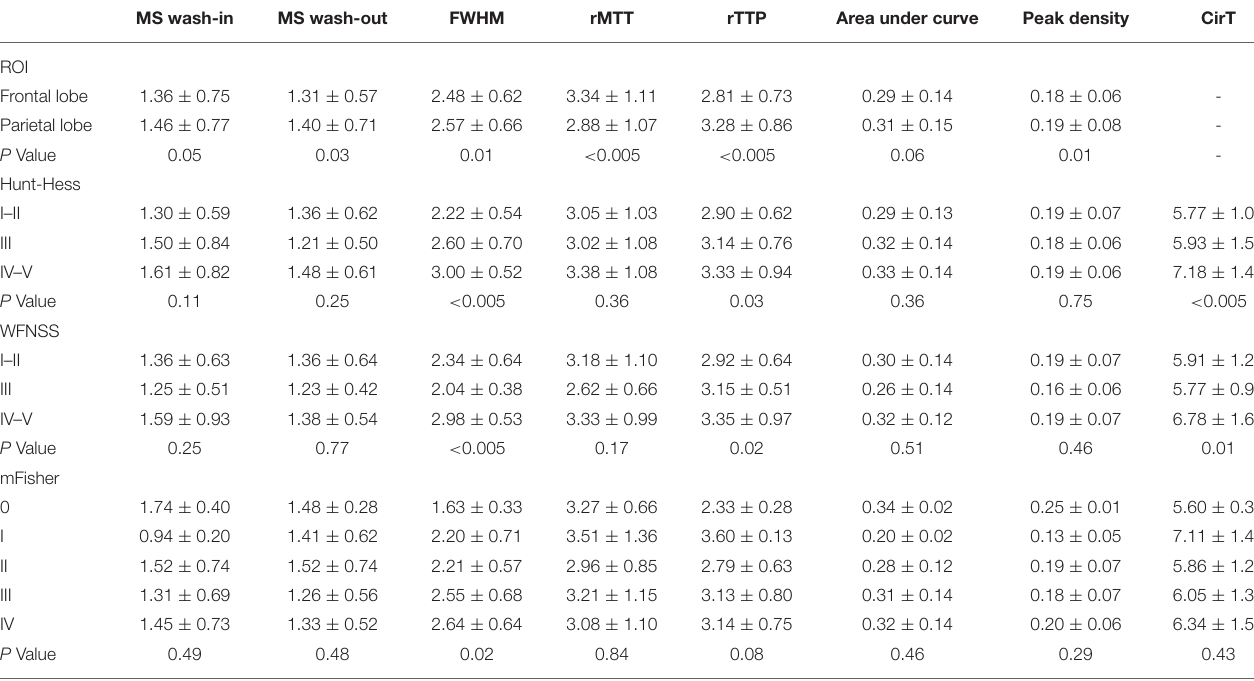
TABLE 2 | Comparison of hemodynamic parameters derived from the time-density curve with clinical features. MS wash-in MS wash-out FWHM rMTT rTTP Area under curve Peak density CirT